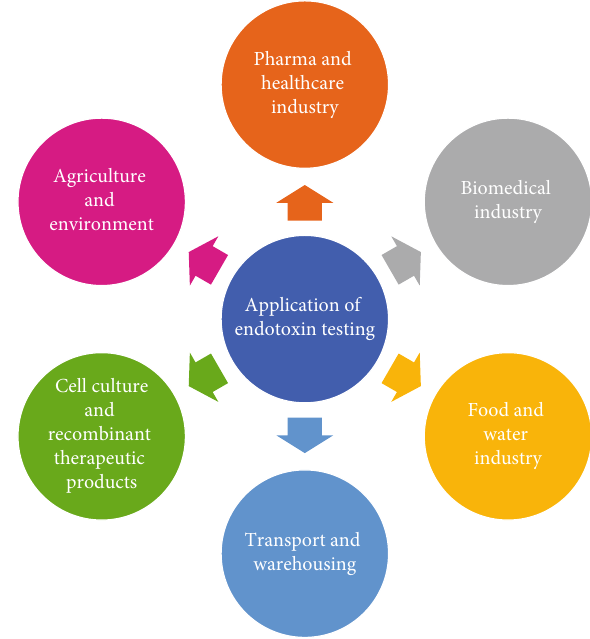
Figure 10: Application of LAL